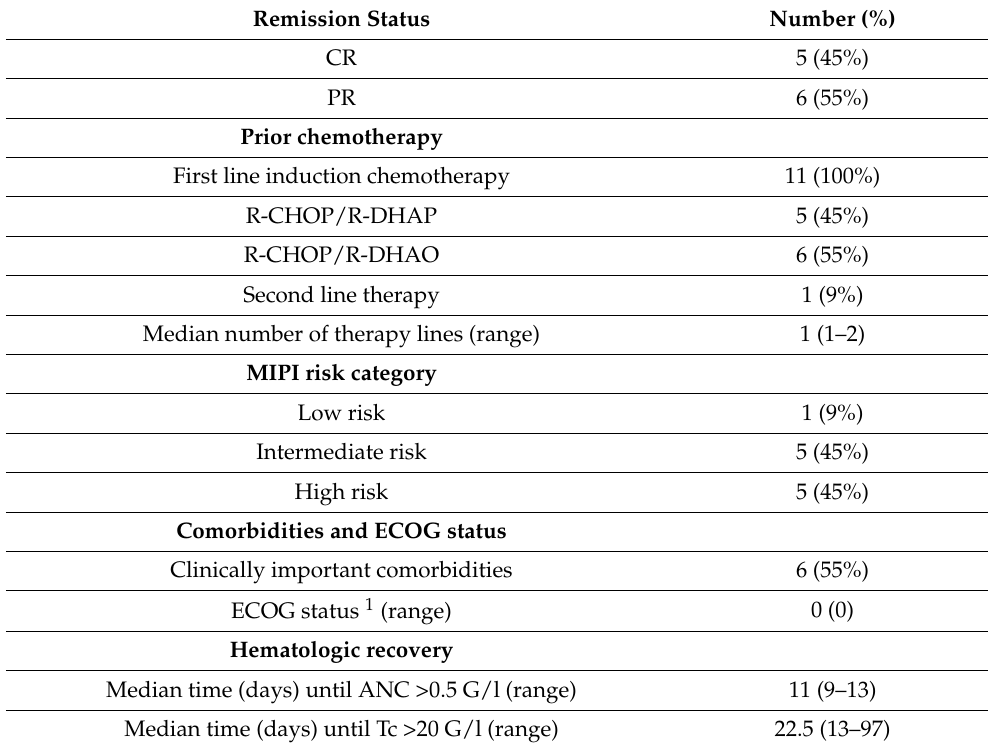
Table 2. Clinical status of the patients at the time of